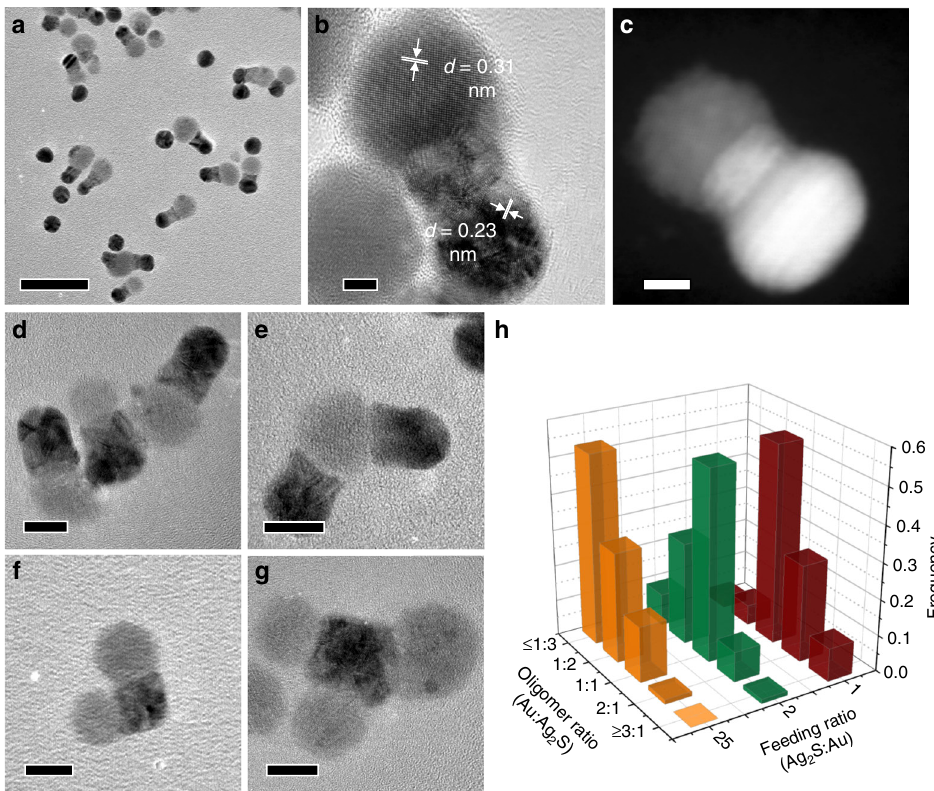
Fig. 1 Formation of Au – Ag 2 S oligomer-like HNPs through welding of spherical Au and Ag 2 S NPs. a TEM image of welded Au – Ag 2 S HNPs, b HRTEM, and c HAADF-STEM images of individual Au – Ag 2 S dimer formed by welding Au and Ag 2 S NPs in dispersion. d – g TEM images of Au – Ag 2 S HNPs with different Au:Ag 2 S domain ratios: d 1:1, e 2:1, f 1:2, and g 1:3. h Statistical histogram showing the Au:Ag 2 S domain ratio of derived Au – Ag 2 S HNPs at different feeding ratios of Ag 2 S:Au NPs. Scale bars are 50 nm in a , 5 nm in b , c , and 10 nm in d –